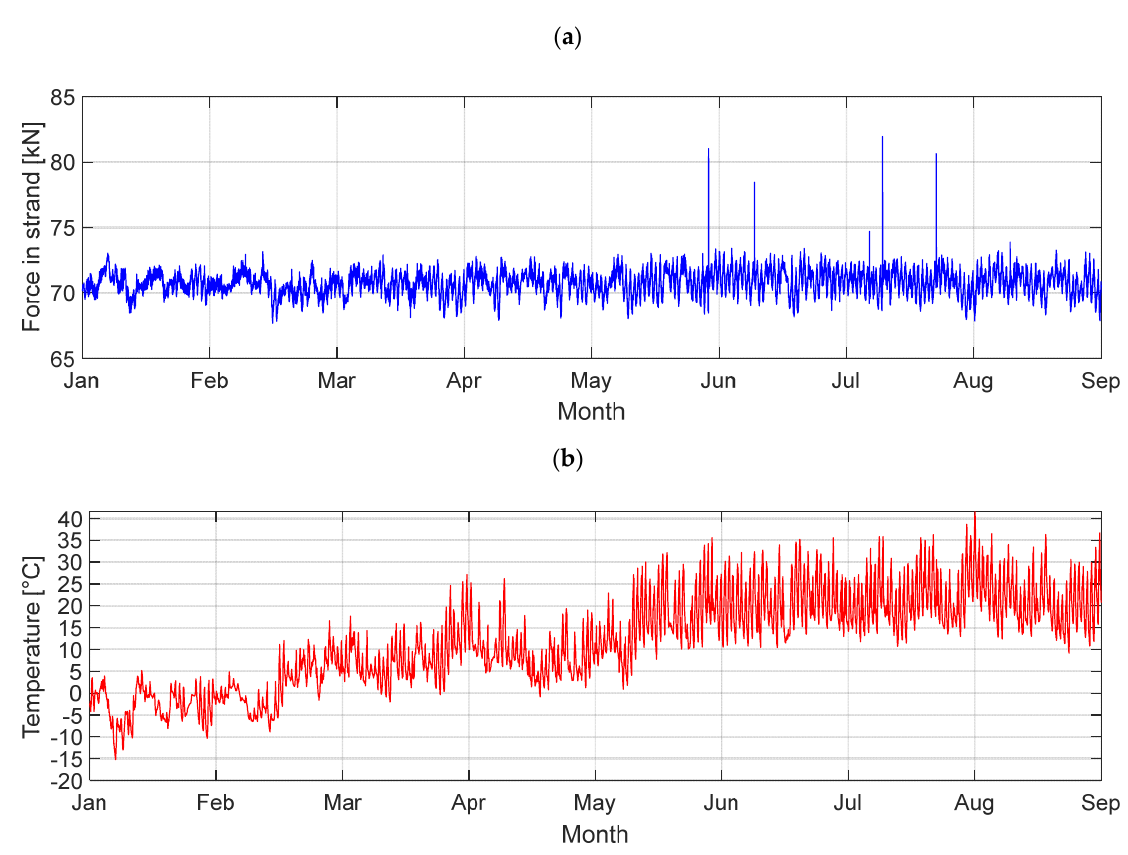
Figure 6. The diagrams in the longest cable LW-40: ( a ) force diagram; ( b ) temperature diagram. Table 5. Measured temperature differences in structure elements.